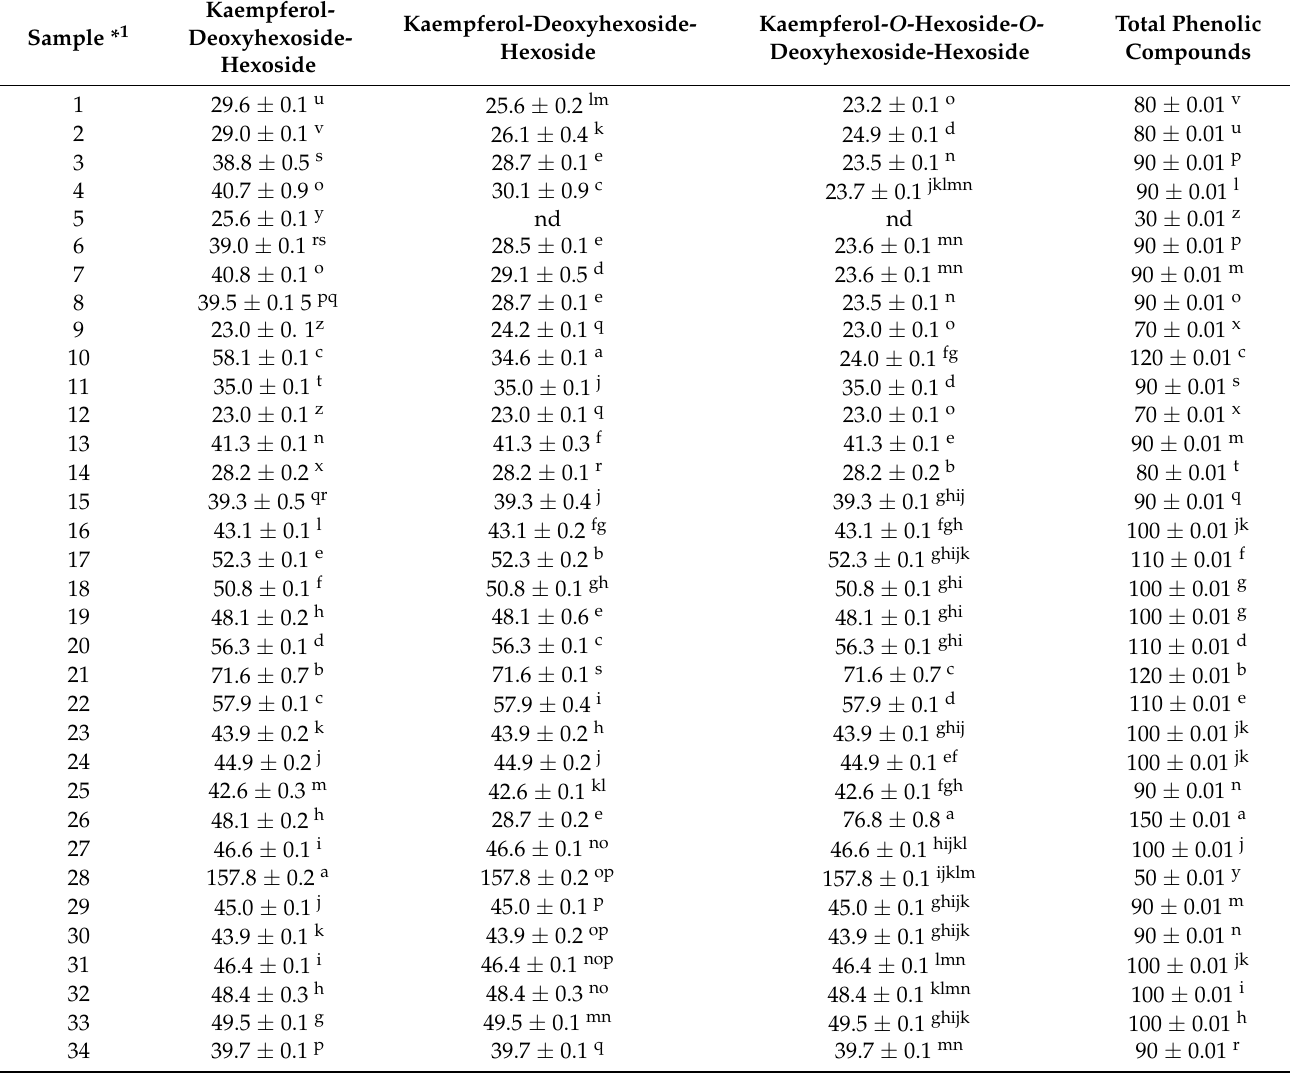
Table 6. Phenolic compounds ( µ g/100 g fw) of the studied Pardina lentil “Lenteja de Tierra de Campos” (mean ± SD, n =